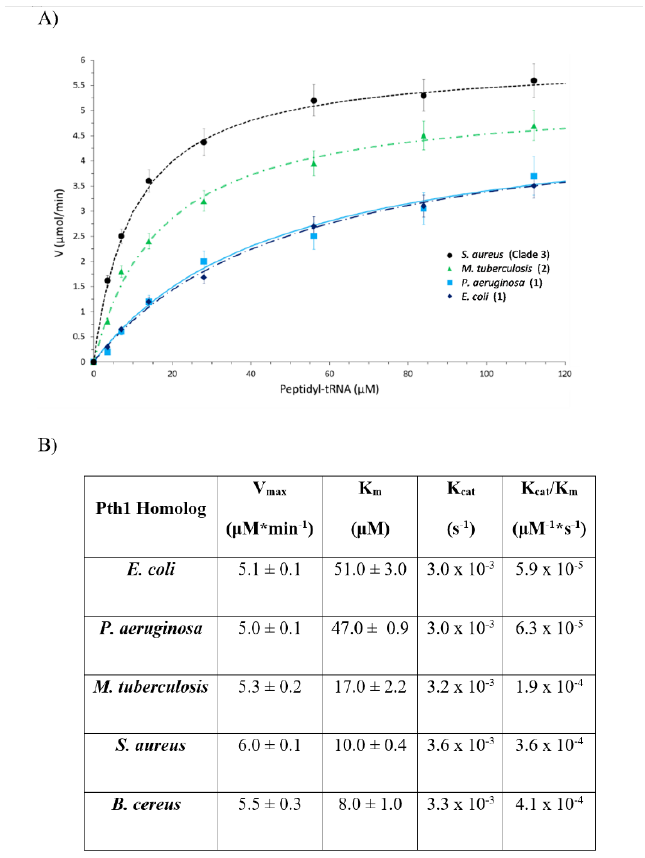
Figure 7. Comparison of Kinetic Parameters for Pth1 from Different Phylogenetic Clades. ( A ) Plots of enzyme velocity versus substrate concentration are shown for Pth1 from E. coli , P. aeruginosa , M. tuberculosis , and S. aureus . The representative clade is indicated in parenthesis. ( B ) Table showing a summary of kinetic parameters for Pth1 tested.